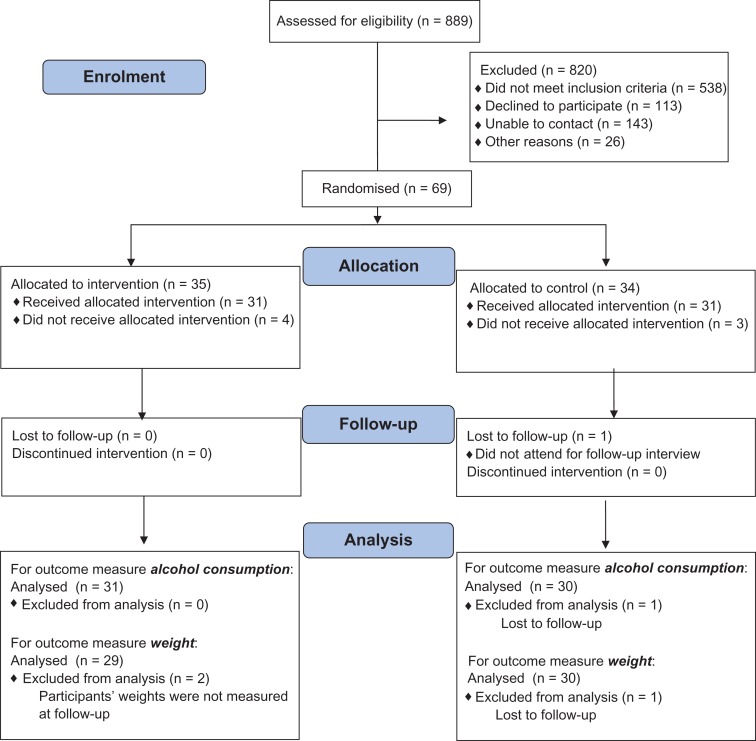
Study flow diagram.